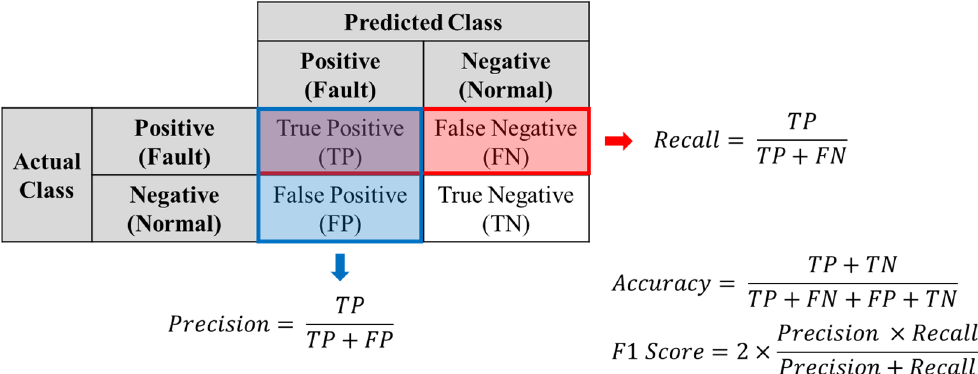
Figure 7. Evaluation metrics for the classification model prediction.